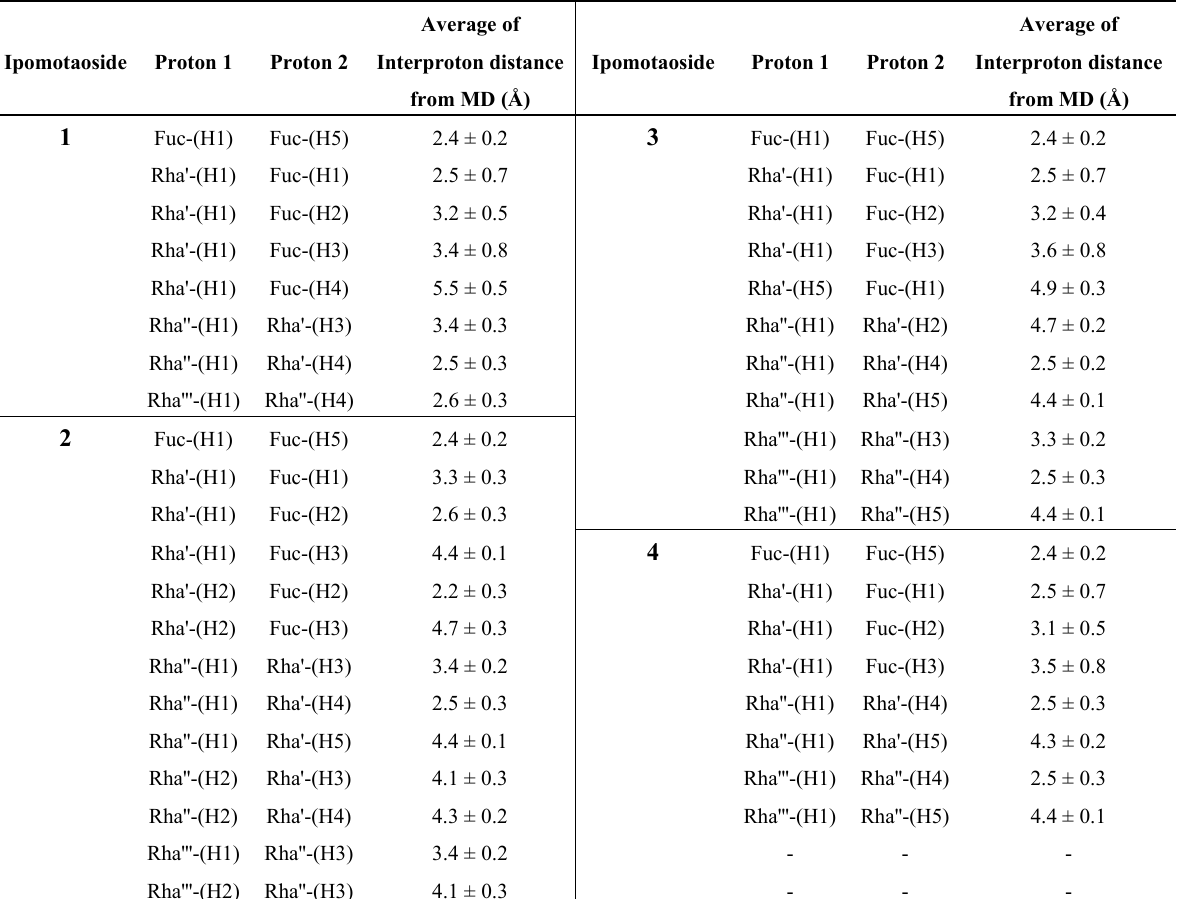
Table 2. Comparison between ROESY * contacts of Ipomotaosides and the interproton distances from MD